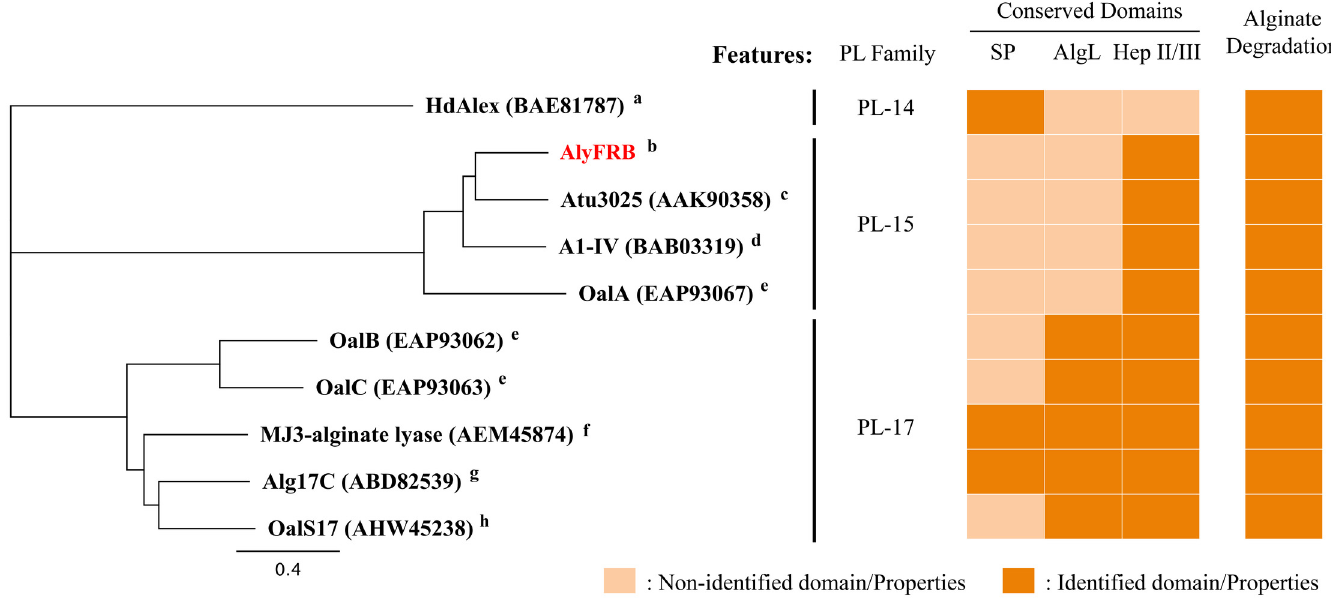
Fig 5. Phylogenetic analysis of currently reported oligoalginate lyases with AlyFRB. Accession numbers of each enzyme are shown in parentheses. Alphabets describe the host origin of the oligoalginate lyase. a Haliotis discus hannai (abalone), b Falsirhodobacter sp. alg1, c Agrobacterium fabrum str. C58, d Sphingomonas sp. strain A1, e Vibrio splendidus 12B01, f Sphingomonas sp. MJ-3, g Saccharophagus degradans 2 – 40, h Shewanella sp. Kz7. HdAlex was assigned as the